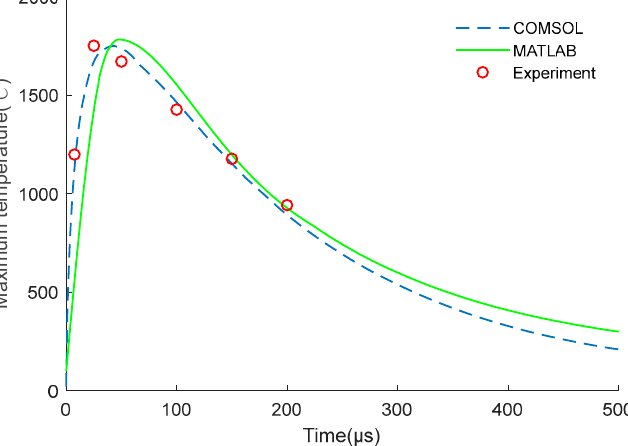
Figure 8. Simulation and experimental data under capacitive discharge.